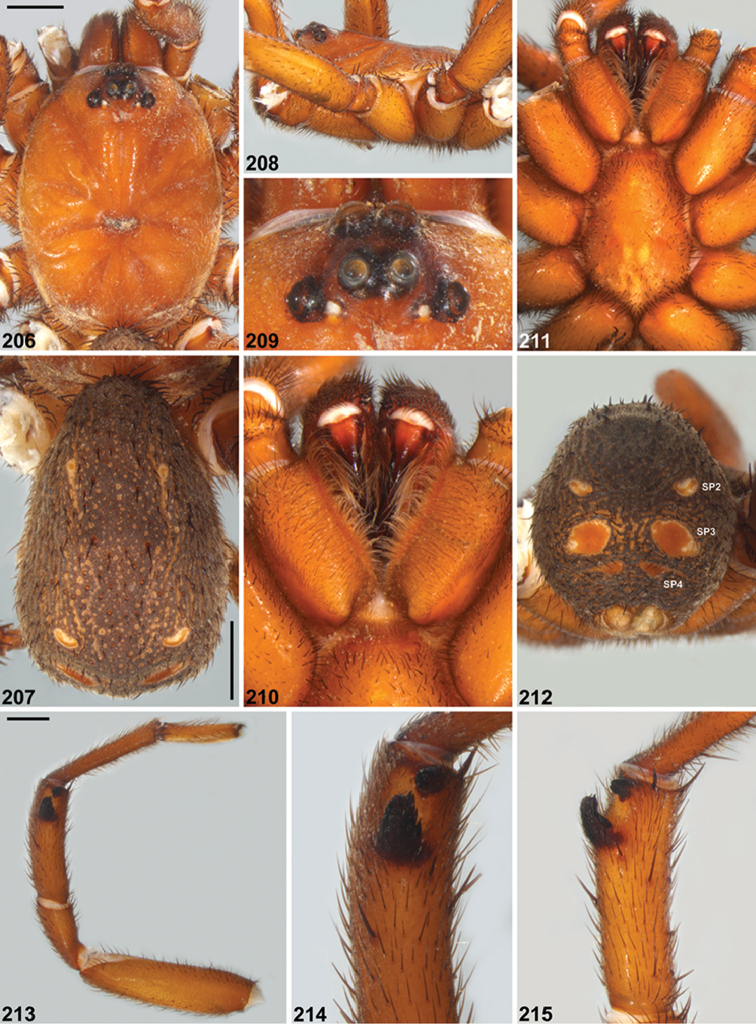

Idiosoma
intermedium sp. n., male holotype (WAM T139520) from Bodallin (Western Australia; AVW), somatic morphology. 206–207 Carapace and abdomen, dorsal view 208 Carapace, lateral view 209 Eyes, dorsal view 210 Mouthparts, ventral view 211 Sternum, ventral view 212 Abdomen, posterior view 213 Leg I, prolateral view 214 Leg I tibia, clasping spurs, prolateral view 215 Leg I tibia, proventral view. Scale bars 2.0. SP2–4 = sigilla pairs 2–4.